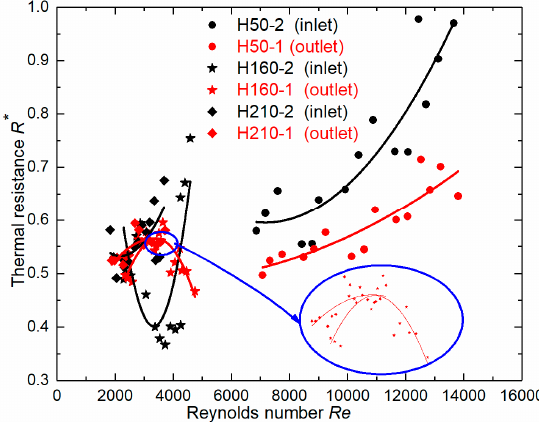
Figure 13. Modified entropy generation rate ( N (cid:48) s ) versus Reynolds number ( R e ).